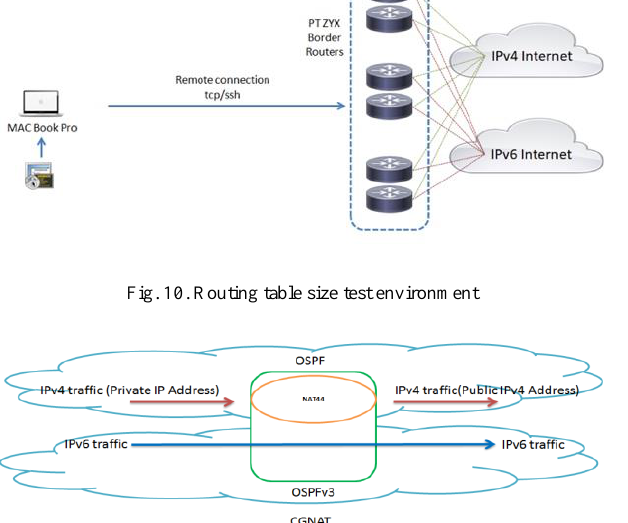
Fig. 11. CGNAT with dual stack traffic architecture